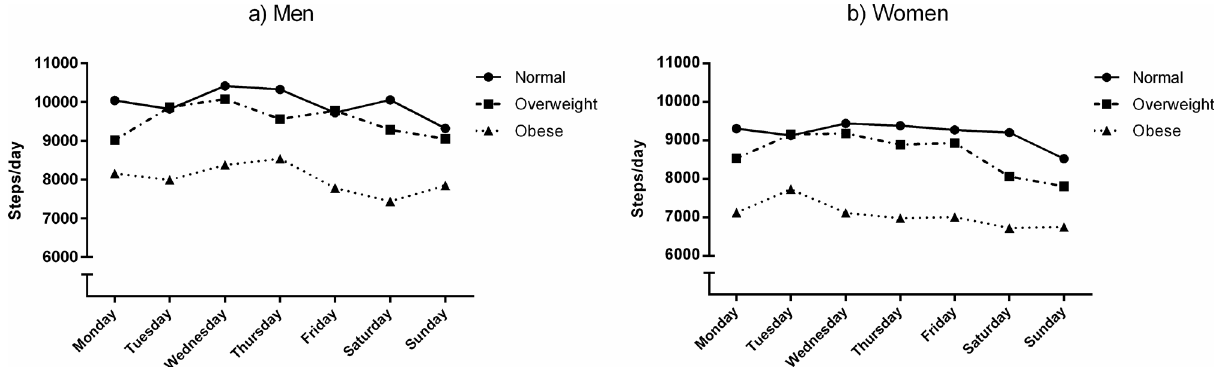
Figure 4. Variability in mean steps/day for each day of the week in three BMI groups in men (a) and women